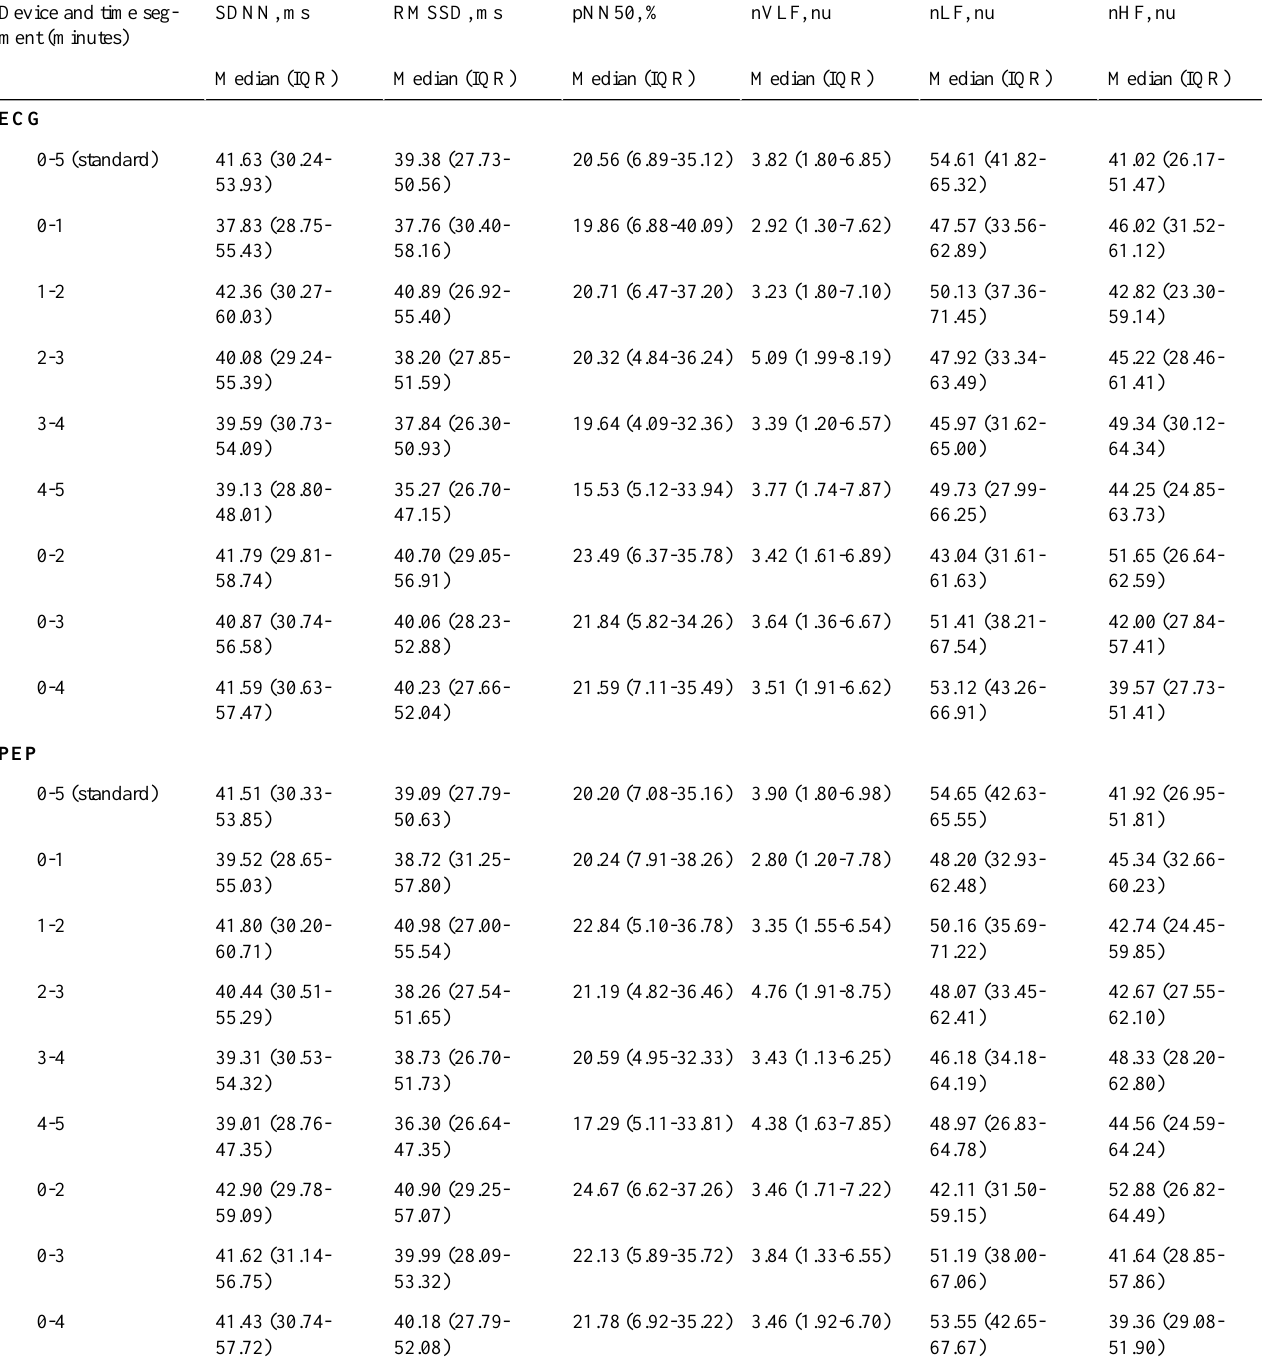
Table 1. Median and interquartile range (25%-75%) of time-domain and frequency-domain heart rate variability parameters in different time segments of the electrocardiogram and Pulse Express PRO measurements a